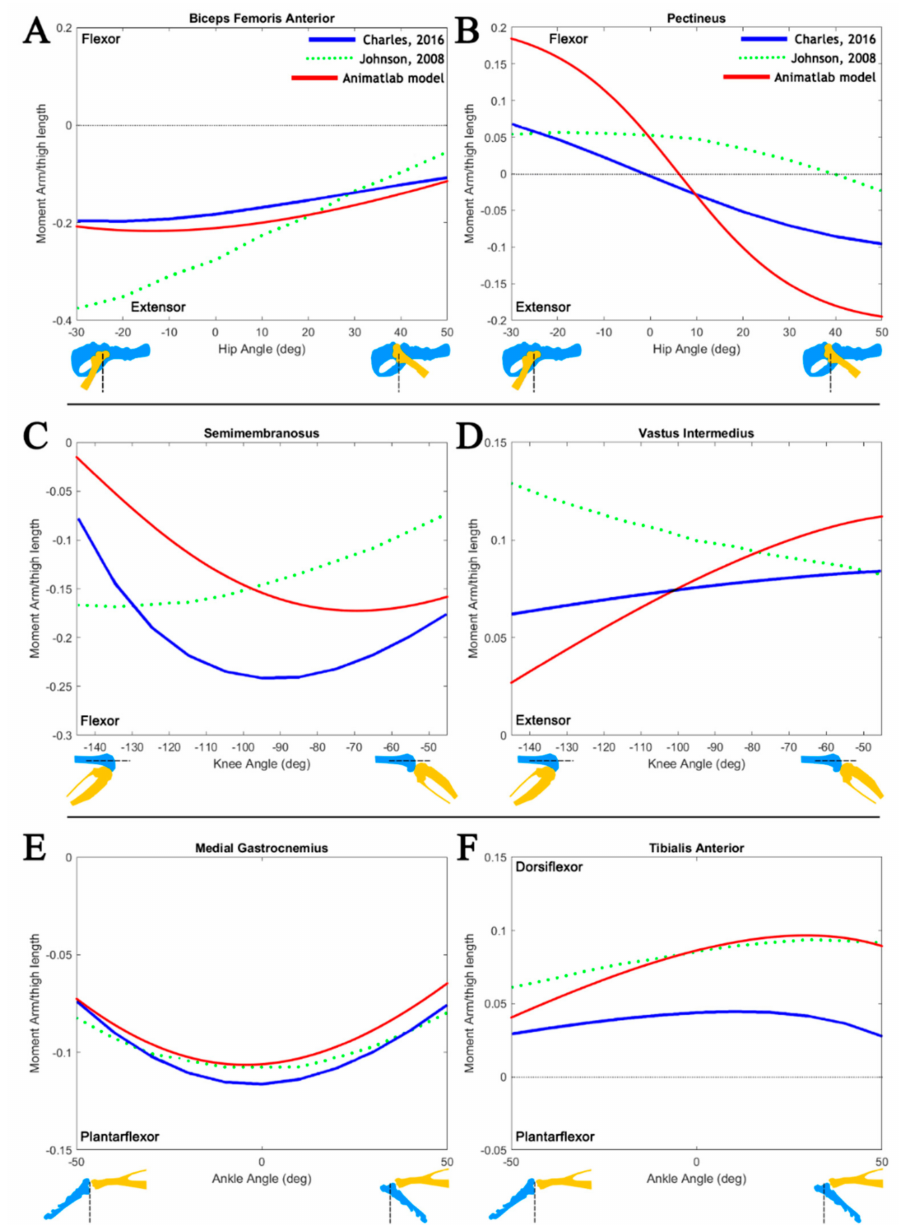
Figure 6. Comparison of hindlimb moment arms calculated using the AnimatLab model to data from Johnson et al. [17] and Charles et al. [18] (data adopted from [18], published under the Creative Commons Attribution (CC BY) license [24]). Moment arm profiles were developed for muscles under single-joint motion of ( A , B ) the hip, ( C , D ) knee, and ( E , F ) ankle. Joint angles follow the zero-angle convention established in the existing models. Joint configurations (yellow/blue) are provided for reference with the zero-angle noted. y -Axes are moment arm lengths normalized to the model’s femur